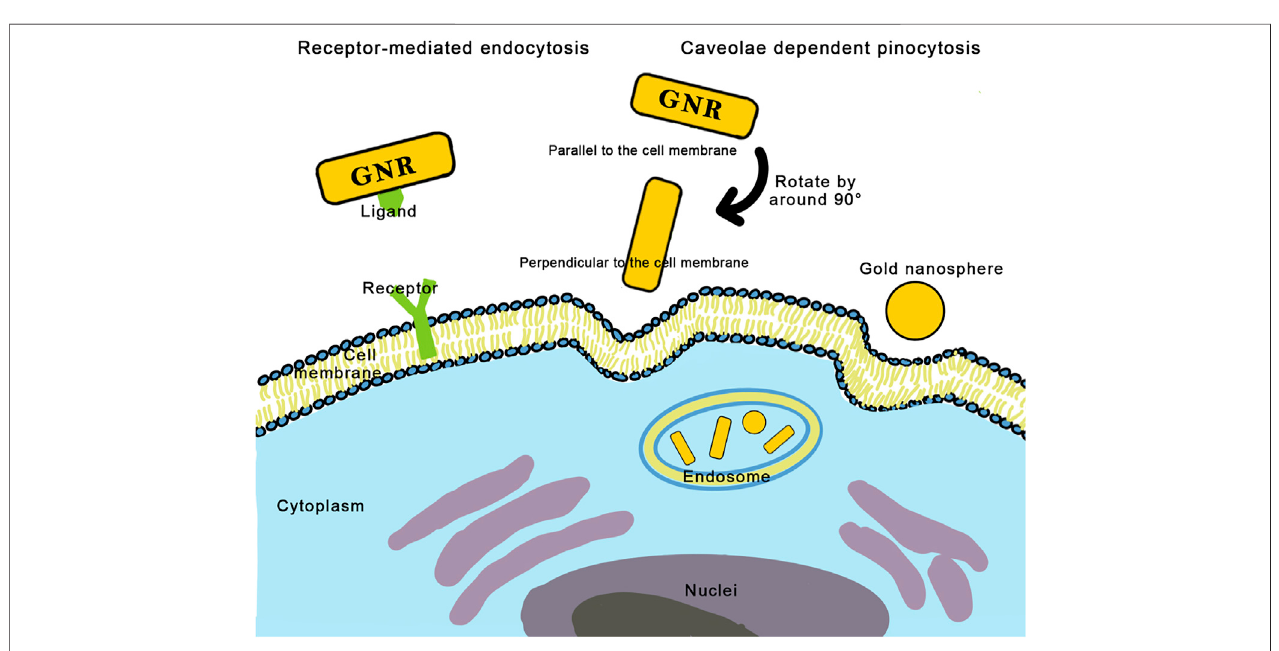
FIGURE 3| Two mechanisms of cellular uptake ofgold nanorods: receptor-mediated endocytosis and caveolae dependent pinocytosis. Long nanorods pre-align to the cell membrane almost parallelly, then rotate by around 90 ° to enter the cell, while short nanorods can directly be entrapped by cells without rotation.